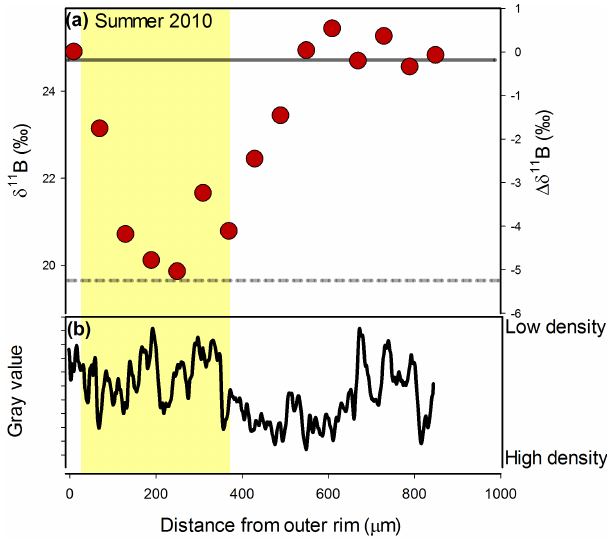
Figure 2. (a) δ 11 B measurements of mesophotic (60m) Stylophora pistillata coral documented to undergo bleaching during sum- mer 2010 (Nir et al., 2014). (b) Skeleton density, reported as the gray value of pixels along the ablation transect. Yellow shaded area represents the low-density skeleton band deposited in summer 2010. Solid and dashed gray lines represent the expected δ 11 B value for pH sw = 8 . 2 calculated with boron isotope equilibrium constant ( 11 − 10 K B ) of Klochko et al. (2006) (not accounted for vital effect) and an empirical coefficient specific to this species (with symbionts) by Krief et al. (2010),